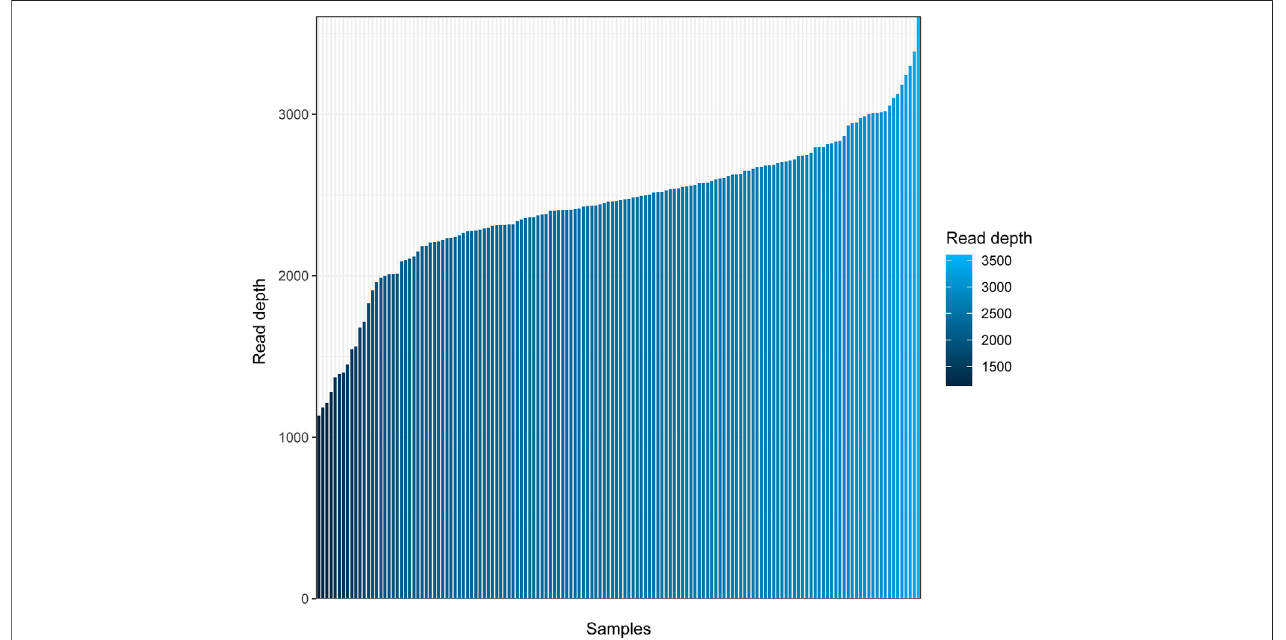
FIGURE1| Readdepthforthecompletemitochondrialgenomeof146Daurindividuals.Thehorizontalaxisrepresentsthedifferentindividualssortedfromsmallto large according to the mean sequencing depth, and the vertical axis represents the average read depth.